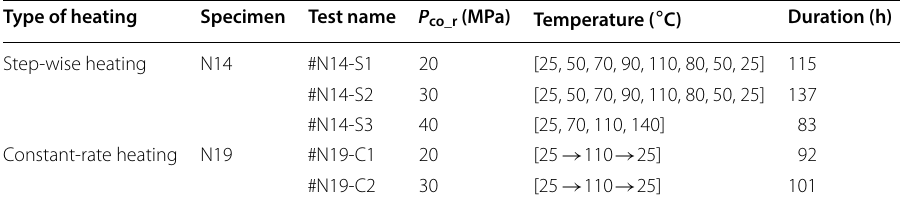
Table 2 Experiment